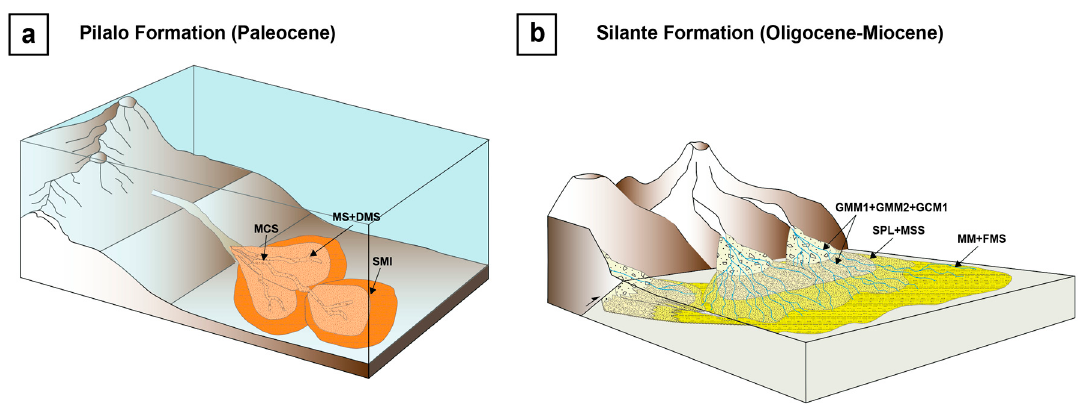
Figure 8. Depositional models for the Pilalo and Silante formations. ( a ) Submarine fan depositional model of the Pilalo Formation, ( b ) debris flow dominated alluvial fan model of the Silante